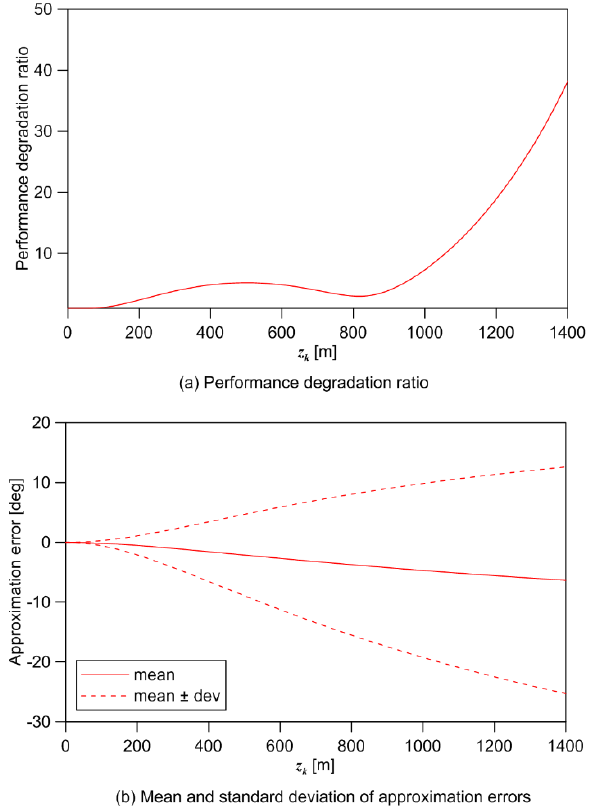
Figure 5. ( a ) Performance degradation ratio and ( b ) the approximation error statistics.